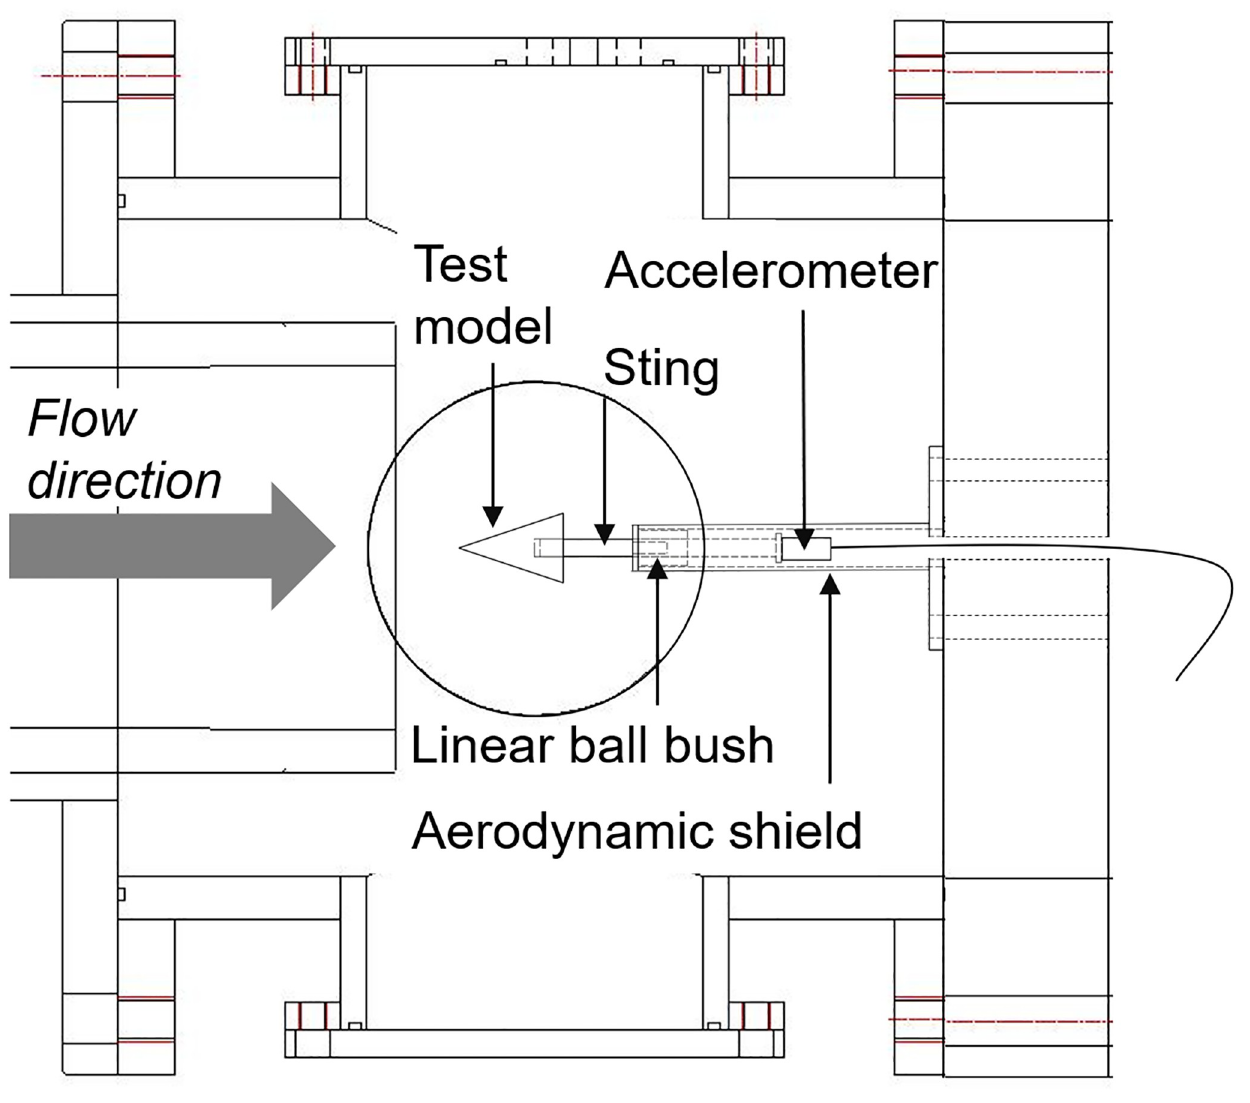
Fig 4. Schematic of the MST